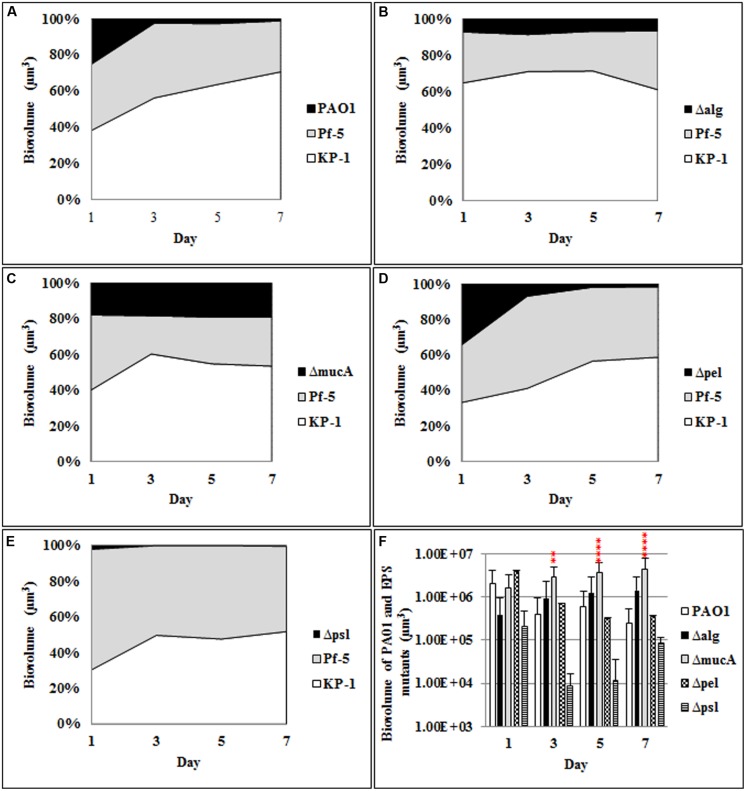
Spatial and temporal development of Pseudomonas aeruginosa polysaccharide mutants grown with P. protegens and Klebsiella pneumoniae as three species biofilms. The proportion of the three species within the mixed species over the 7 days period was determined by quantitative image analysis. (A)
P. aeruginosa wild-type (WT), (B) Δalg, (C) ΔmucA, (D) Δpel, (E) Δpsl, and (F) biovolumes of P. aeruginosa WT and polysaccharide mutants. Statistical analysis was performed vs. the corresponding WT samples grown in parallel **P < 0.01, ****P < 0.0001.